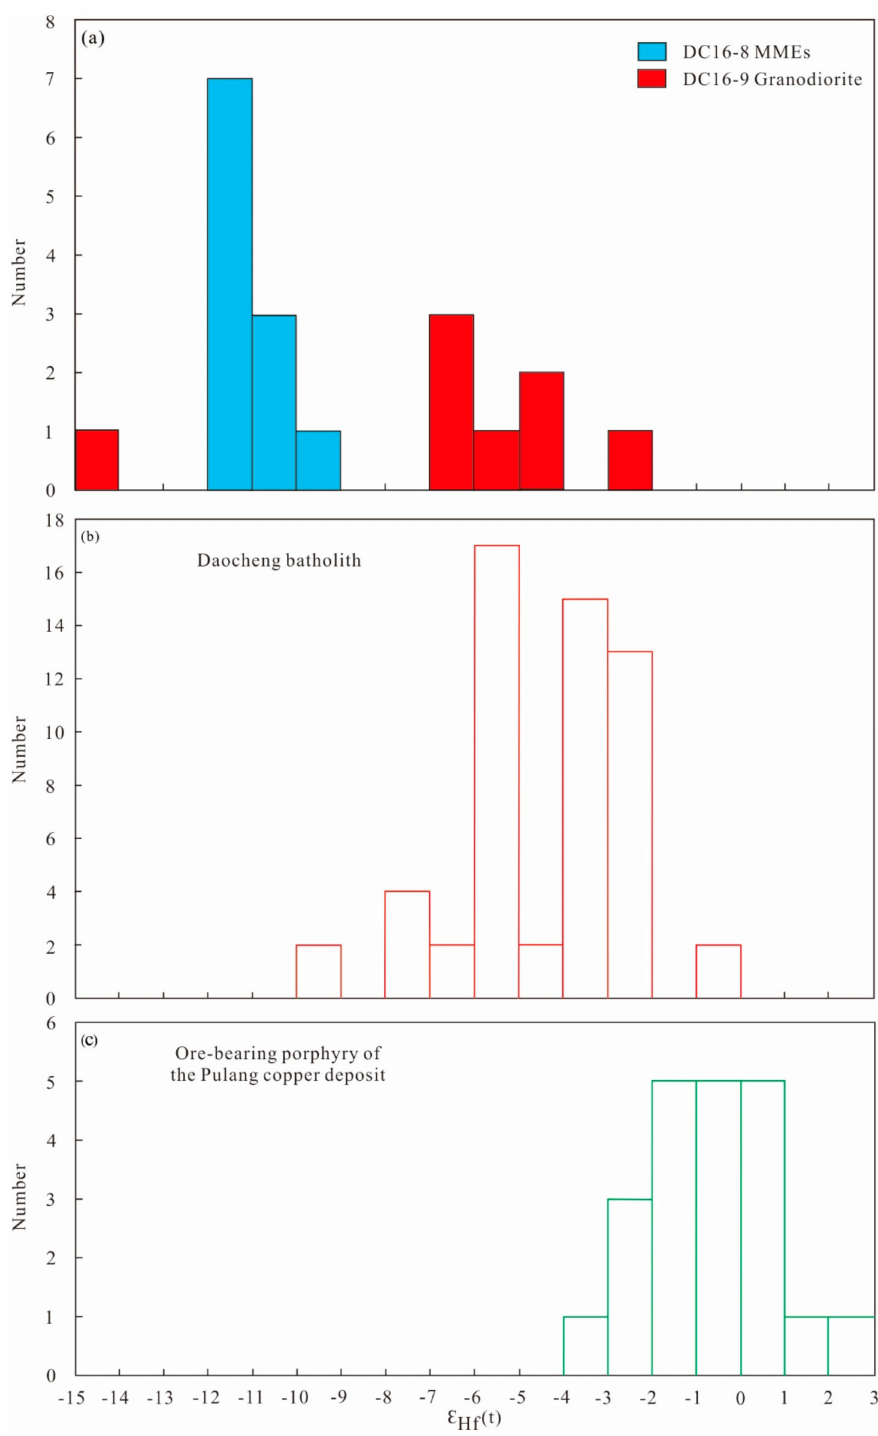
Figure 8. Histograms of zircon ε Hf (t) values for the Daocheng batholith. Note: The data for granodiorite from [17,18]; the data for ore-bearing porphyry of the Pulang copper deposit from [10]. ( a ) histograms of zircon ε Hf (t) values for granodiorite and MMEs; ( b ) histograms of zircon ε Hf (t) values for the Daocheng batholith and ( c ) histograms of zircon ε Hf (t) values for ore-bearing porphyry of the Pulang copper